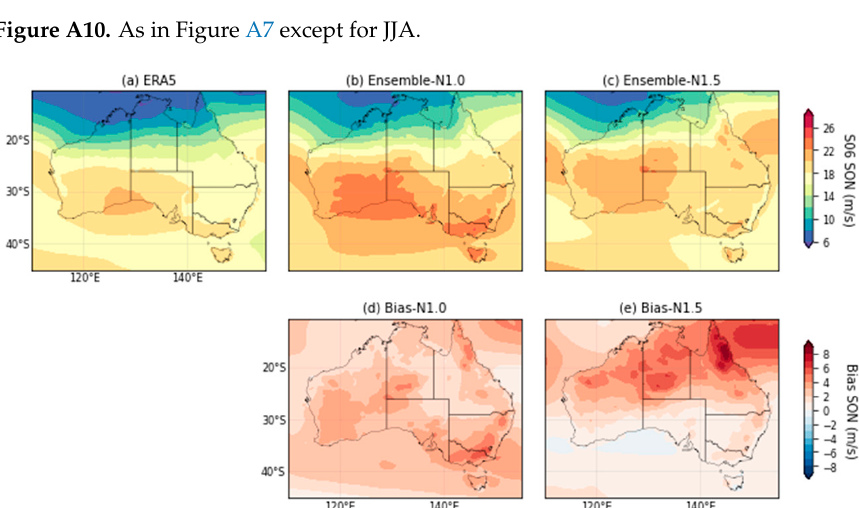
Figure A10. As in Figure A7 except for JJA.